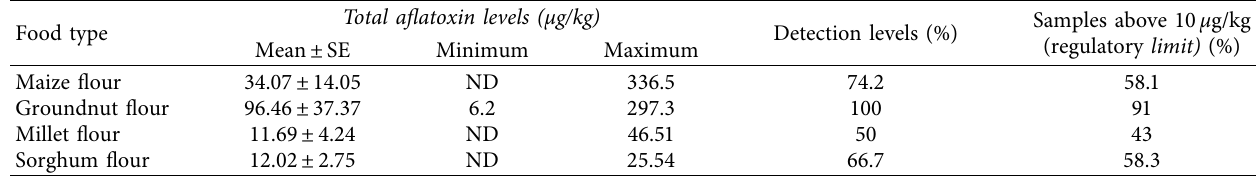
Table 2: Total afatoxin levels in selected food types in S.W. Uganda.